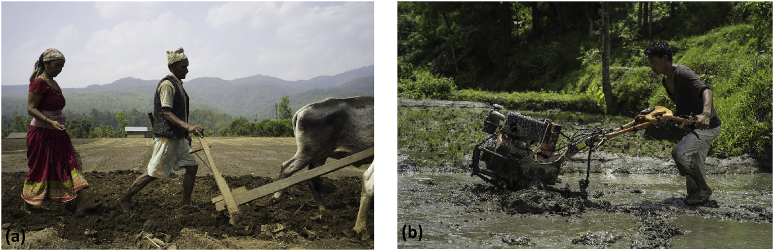
Methods of land preparation: (a) farmers using traditional method of land preparation through bullocks and indigenous plough and (b) farmers using mini-tillers for rice land preparation. Source: Peter Lowe/CIMMYT.